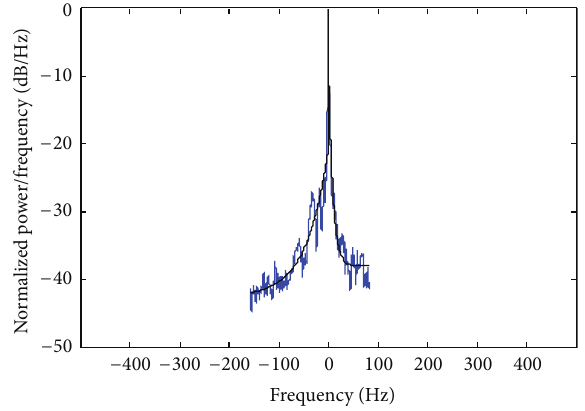
Figure 10: Example B: estimated PSD and corresponding exponen- tial fitting ( 𝑎 = 25.50 , 𝑏 = 4.73 ⋅ 10 −2 , 𝑐 = 51.17 , 𝑑 = 19.40 , 𝑒 = 6.87 ⋅ 10 −2 , 𝑔 = 47.15 , 󳵻𝑓 = 821.82 , and 𝛾 = 0.00 ).